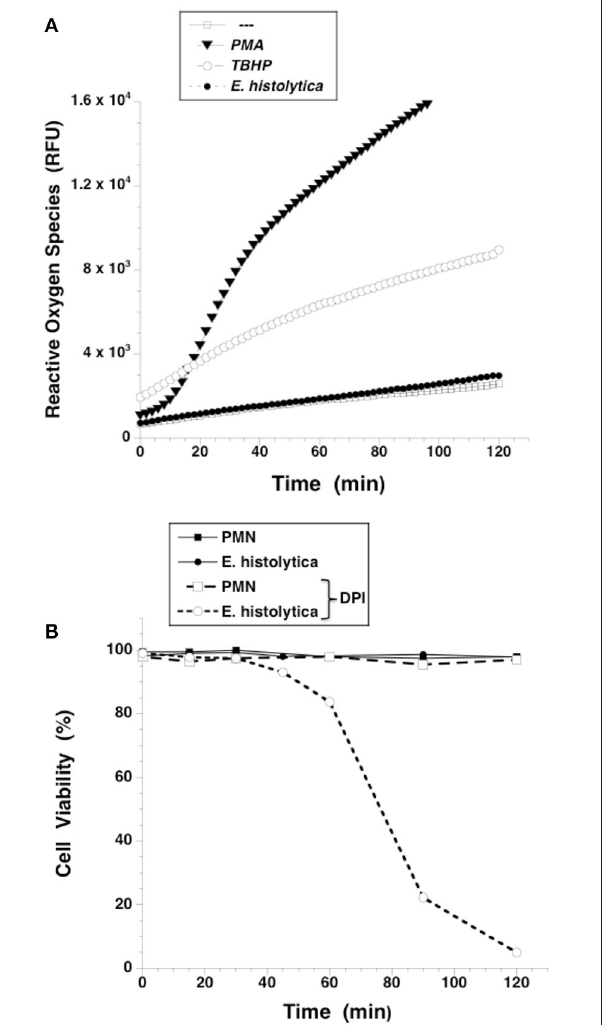
FIGURE 9 | Entamoeba histolytica does not induce Reactive Oxygen Species (ROS) formation. (A) Human neutrophils (PMN) were previously incubated with the ROS-sensitive fluorescent compound DCFDA (15 µ M), and were not stimulated (—), or were stimulated with 20nM phorbol 12-myristate 13-acetate (PMA), or with 200 µ M tert-butyl hydrogen peroxide (TBHP), or with E. histolytica trophozoites. Fluorescence was read in a plate-reader for 2h at 36 ◦ C. Data are mean ± SEM of relative fluoresce units (RFU) from three experiments. (B) Neutrophils (PMN) or E. histolytica trophozoites were treated with solvent alone (black symbols) or with the NADPH-oxidase inhibitor diphenyleneiodonium (DPI) (10 µ M) (white symbols). Cell viability was estimated by Trypan Blue exclusion every